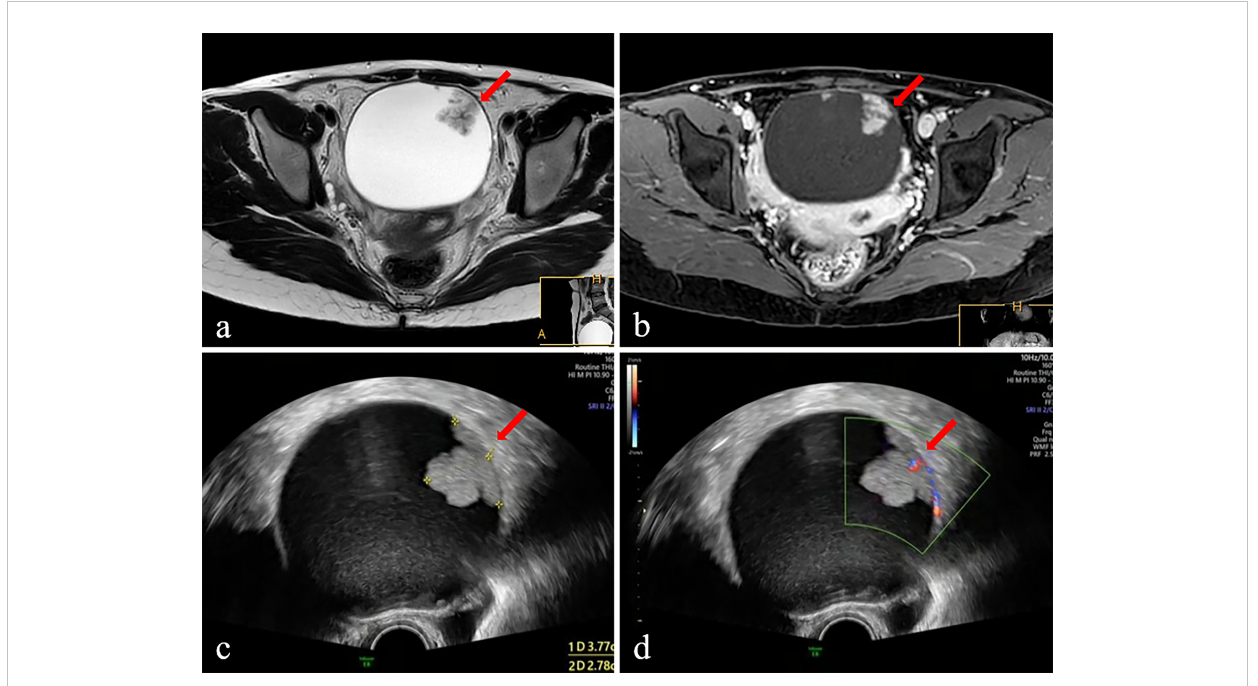
FIGURE 2 The ultrasound and MR images of a 28-year-old female patient with adnexal mass. The mass was diagnosed borderline tumor preoperatively by ADNEX-US and subjective MRI assessment. (A) Axial T 2 WI displays intermediate SI of the solid component (arrow) and high SI of cystic component. (B) Postcontrast axial T1-fat-suppressed image shows obvious persistent enhancement of the solid component (arrow) and walls of the cystic component. (C) Ultrasound images (Gray scale) displayed an anechoic mass with equal echo of the solid component (arrow). (D) Ultrasound images (color Doppler) displayed the solid component of mass has dotted blood fl ow signal. Surgery was performed, and the diagnosis was con fi rmed on histopathology as the borderline